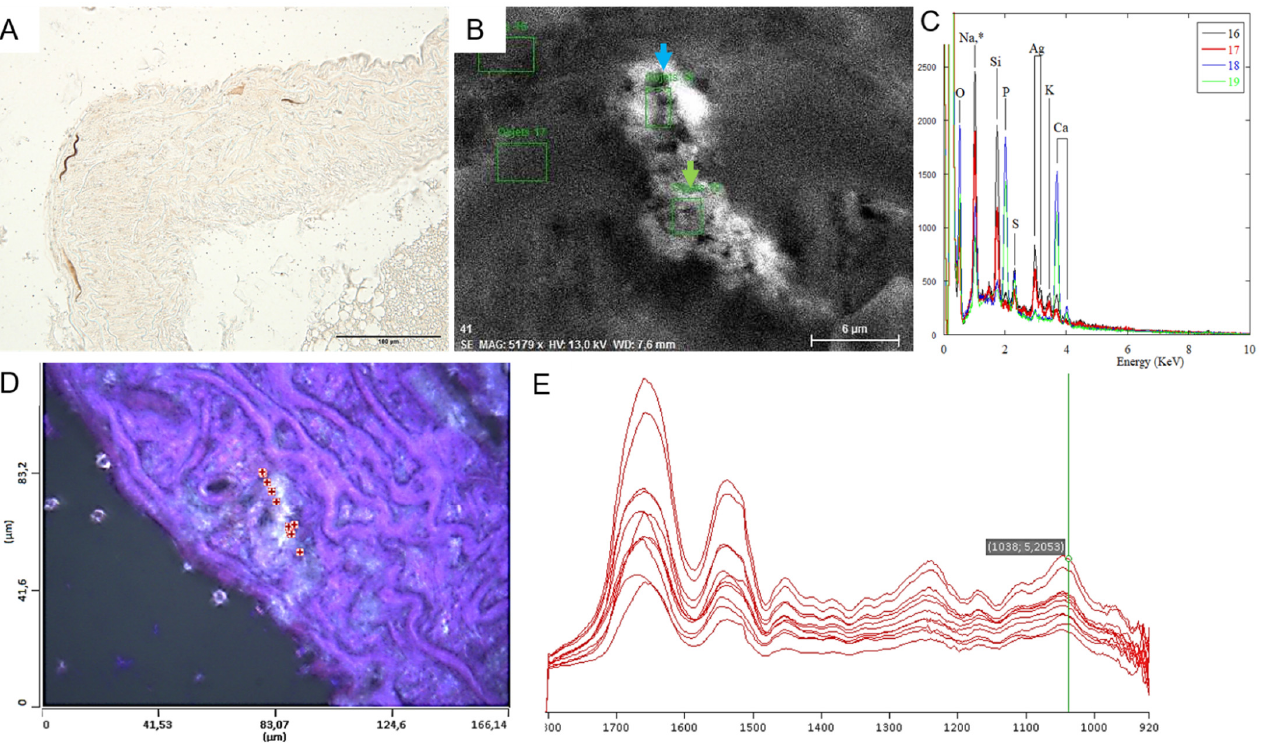
Figure 2. ( A ). Yasue staining of an aorta (Abcc6 − / − mouse exposed to high-calcium + vitamin D) showing that incipient calcification, stai ned in black, seem localized in elastic fibers. ( B , C ). Scanning electron microscopy coupled with EDS evidencing the presence of high amounts of calcium and phosphate in specific areas, at the surface of elastic fibers, corresponding to arrows ( B ) and blue and green peaks ( C ). EDX spectra corresponding to area 16,17,18, and 19 including the different contri- butions coming from the support and the sample namely O (K α = 0.524 KeV), Na (K α = 1.041 KeV), Si (K α = 1.740 KeV), P (K α = 2.013 KeV), S (K α = 2.307 KeV), Ag (L α =2.985 KeV, L β = 3.150 KeV), K (K α =3.310 KeV) and Ca (K α =3.690 KeV, K β = 4.010 KeV). Spectra collected for the support show that Ca and P belong to the calcifications while other elements belong to the support ( D , E ). mIRage spectra reveal the presence of different absorption bands of the apatite including the ν 3 P-O stretching vibration mode measured at 1035–1045 cm − 1 . Carbonate ions are detected together with apatite by their ν 3 C-O stretching vibration mode around 1420 cm − 1 . Each dot in the upper panel corresponds to one